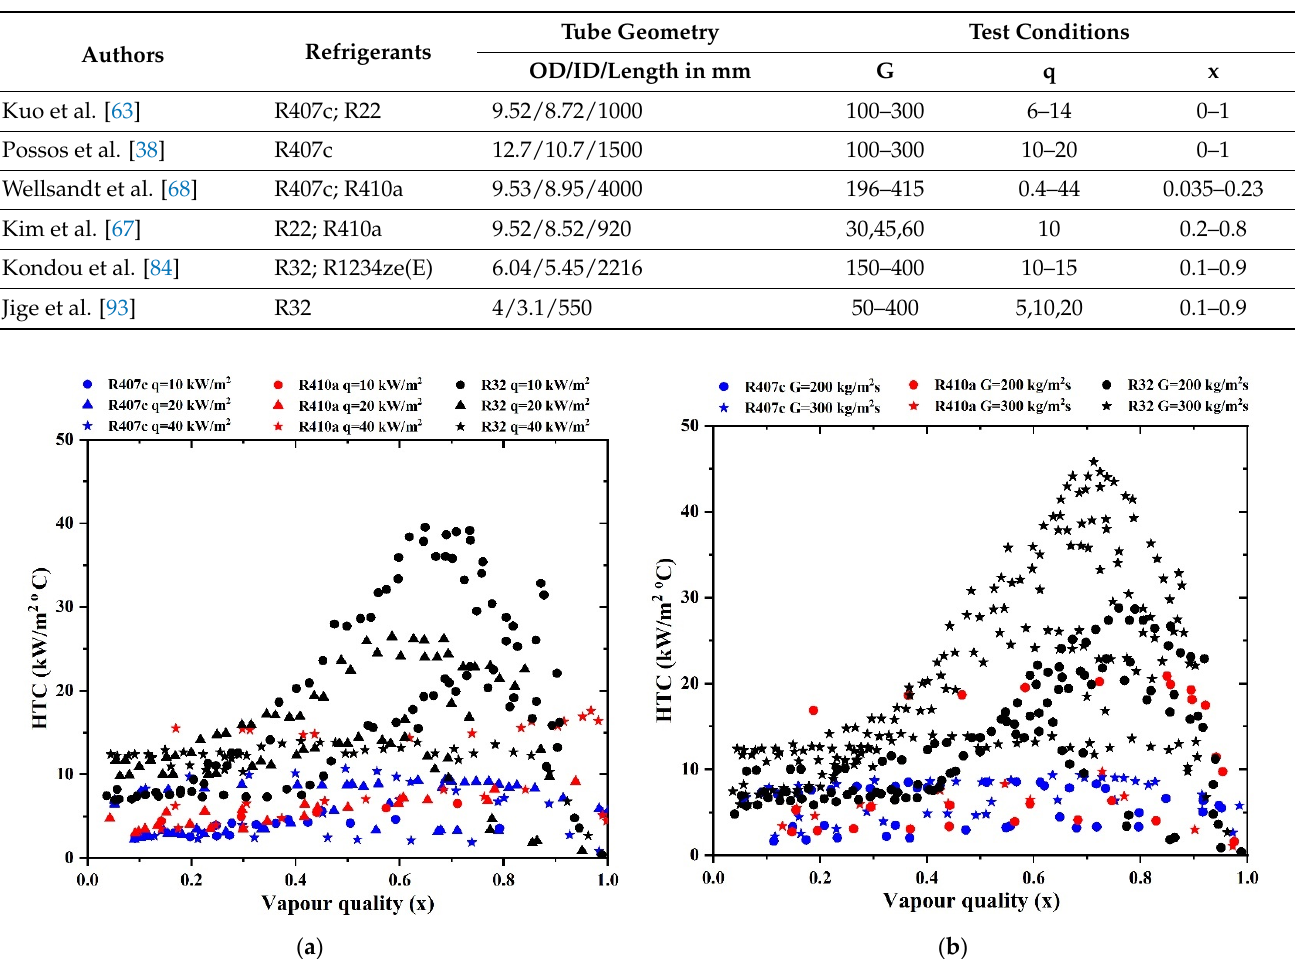
Table 5. Comparison of experimental conditions of different authors regarding results shown above for refrigerants R407c, R410a, and R32 in micro-finned tubes.